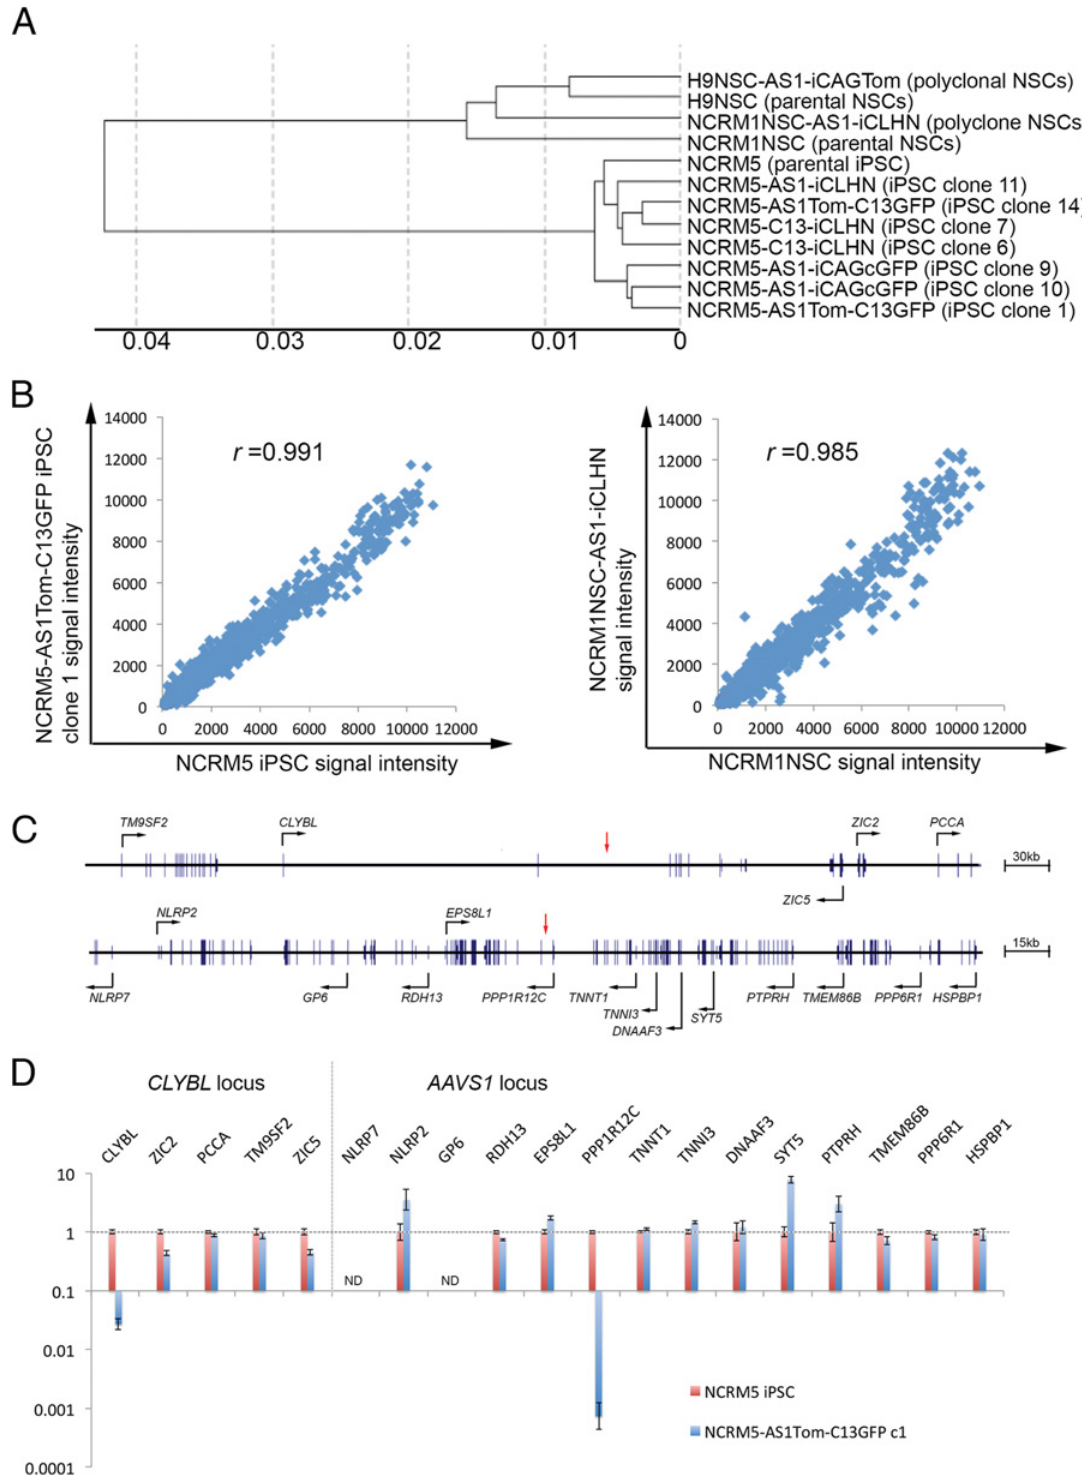
Figure 5. Effect of targeted integrations on global and local gene expression. (A) Dendrogram of non-targeted and safe-harbor targeted iPSCs and NSCs based on microarray analysis. The X-axis represents 1- r (correlation co-efficient). (GEO access# GSE55975) (B) Representatives of global gene expression profile comparison between untargeted and safe-harbor targeted cells. For NCRM5 iPSCs vs dual safe-harbor targeted NCRM5-AS1Tom- C13GFP clone 1, r =0.991. For NCRM1NSC vs AAVS1 targeted polyclonal NCRM1NSC-AS1-iCLHN. r =0.98. (C) Schematic of genomic region surrounding